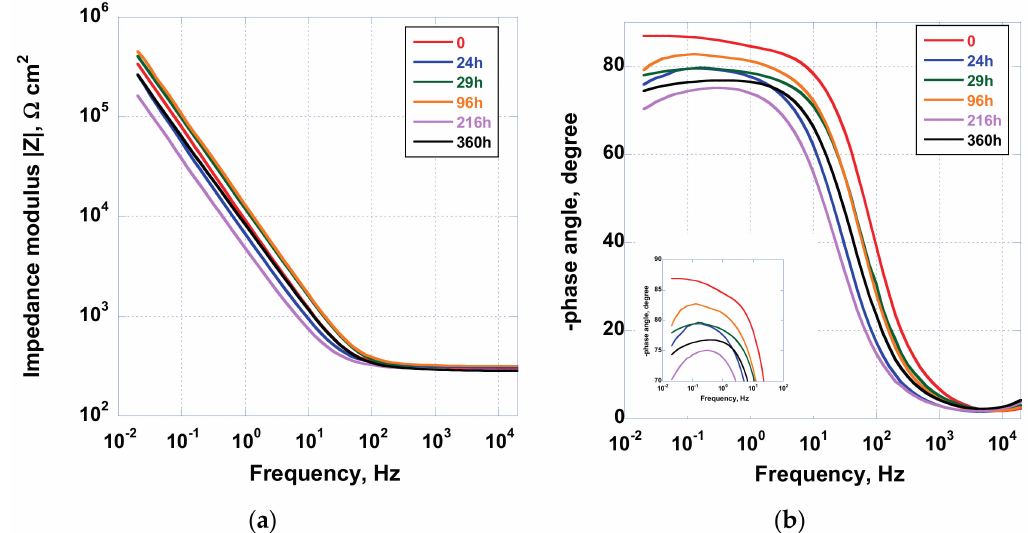
Figure 9. Bode ( a ) and phase angle ( b ) plot acquired for the sample AS when immersed in Hank’s solution for a duration of 360 h.